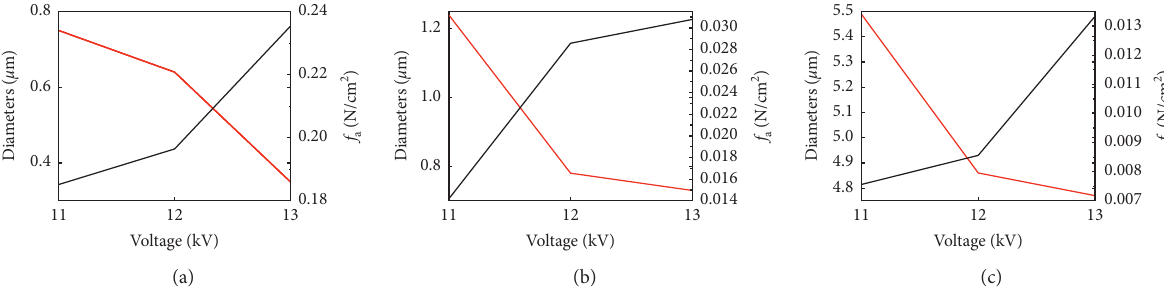
Figure 5: As the spinning voltage increases, adhesion and fiber diameter change. (a) The change of PVP fiber on aluminium foil. (b) The change of PVP fiber on wood pulp paper. (c) The change of PVP fiber on silicone paper.